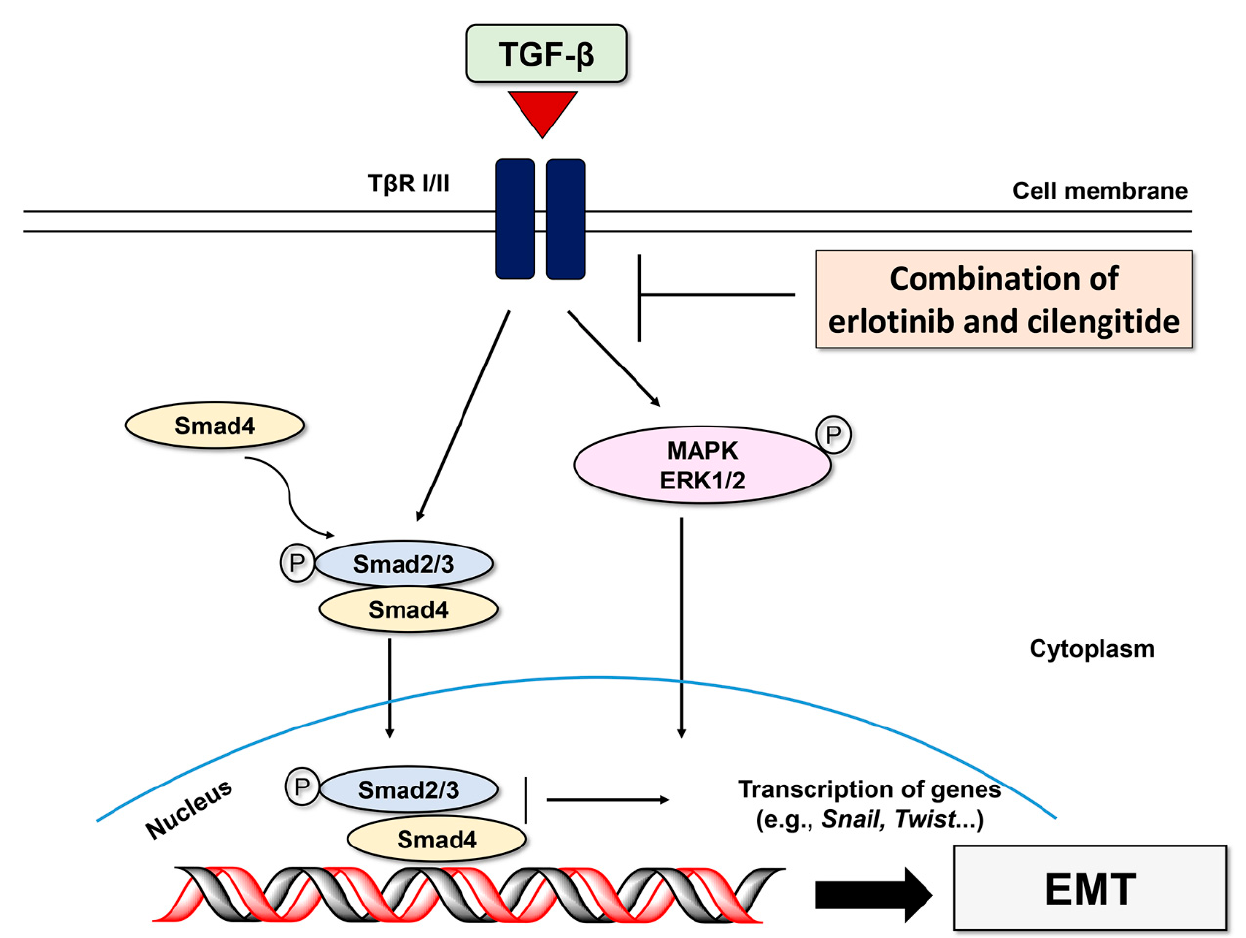
Figure 7. Schematic of TGF- β -mediated EMT signaling pathways inhibited by combined treatment of erlotinib and cilengitide.